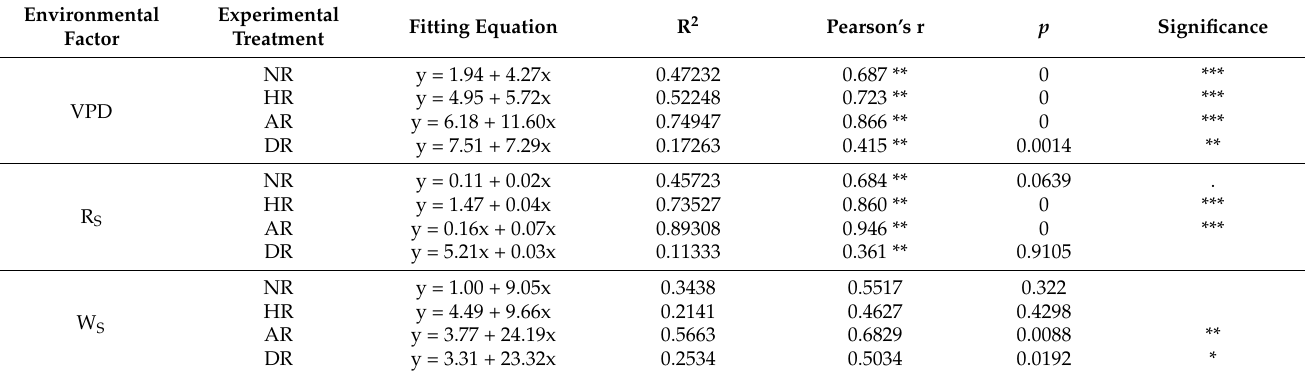
Table 2. Fitted results of daily Q and environmental factors of P. orientalis